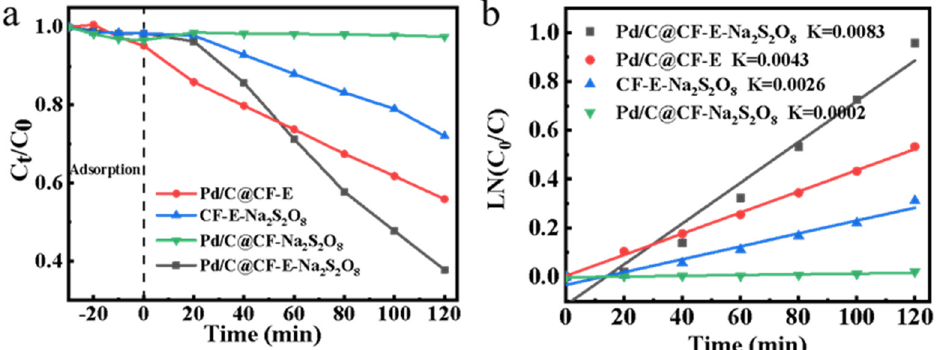
Figure 5. ( a ) Comparison of norfloxacin degradation in various systems; ( b ) the pseudo-first order kinetic rate constants resulting from the different systems shown in ( a ) (electrode area: 10 mm × 10 mm; Na 2 S 2 O 8 , 3 mM; norfloxacin, 10 mg/L; pH, 7.0; applied potential, − 0.8 V vs. Ag/AgCl).